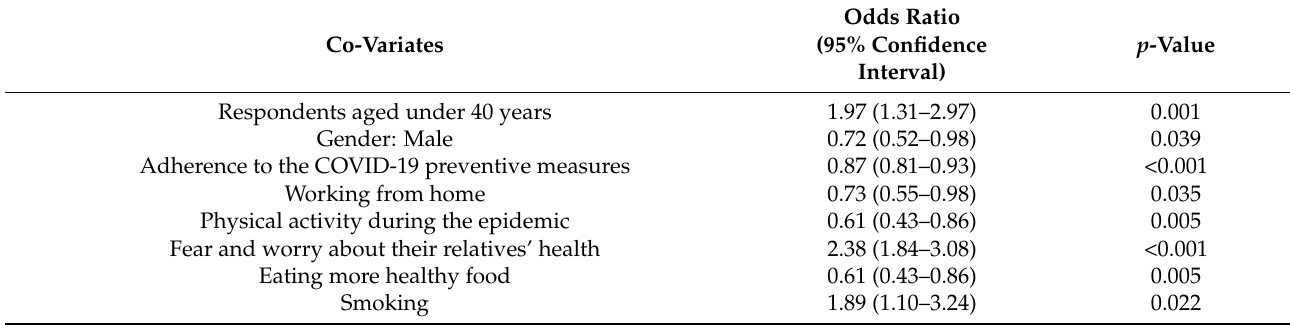
Odds Ratio p -Value (95% Confidence Interval)